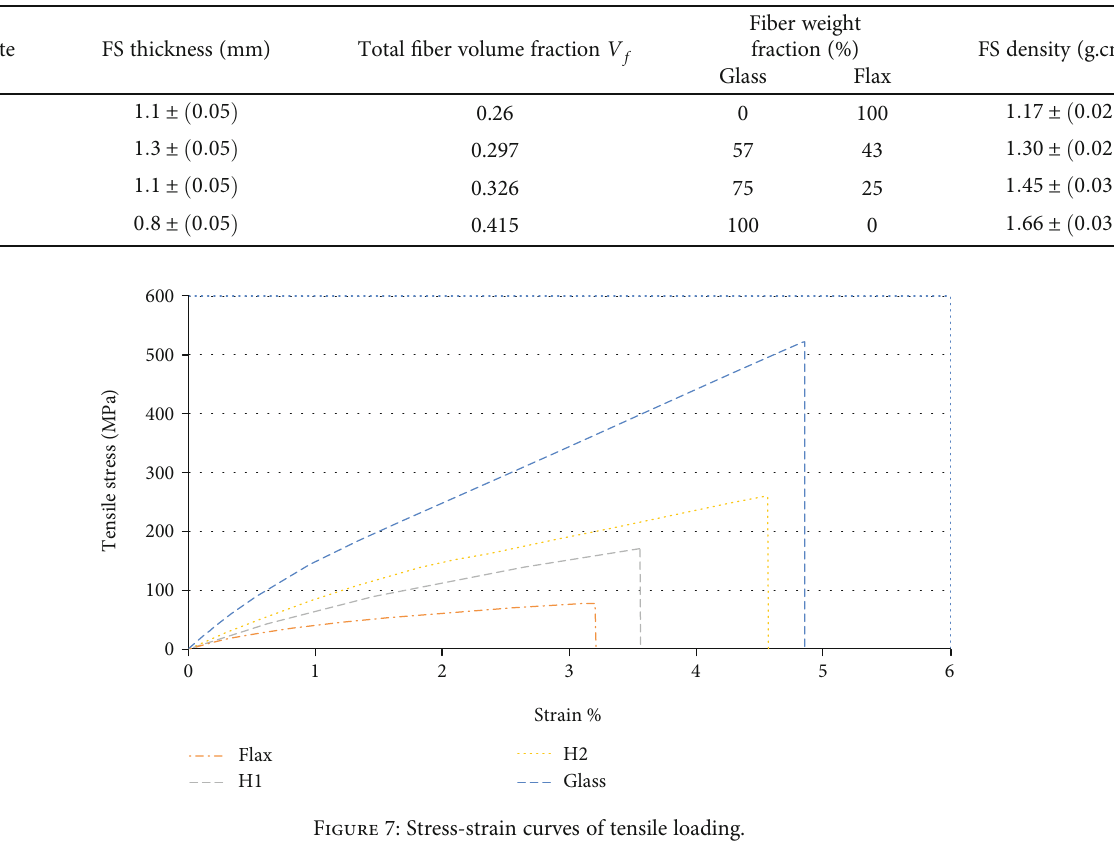
Table 2: Properties of composite